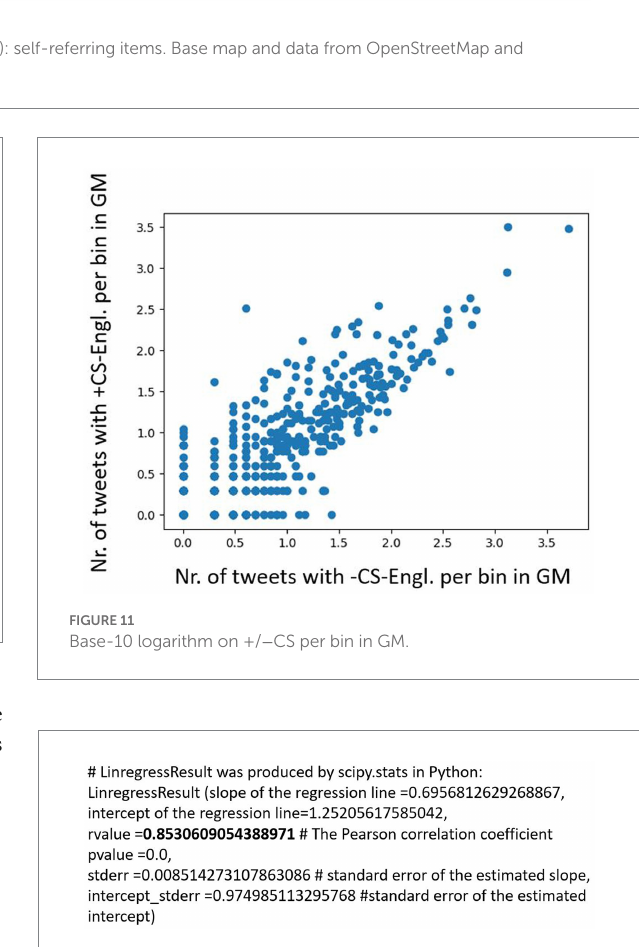
FIGURE 12 Statistics of +/ − CS per bin in GM.